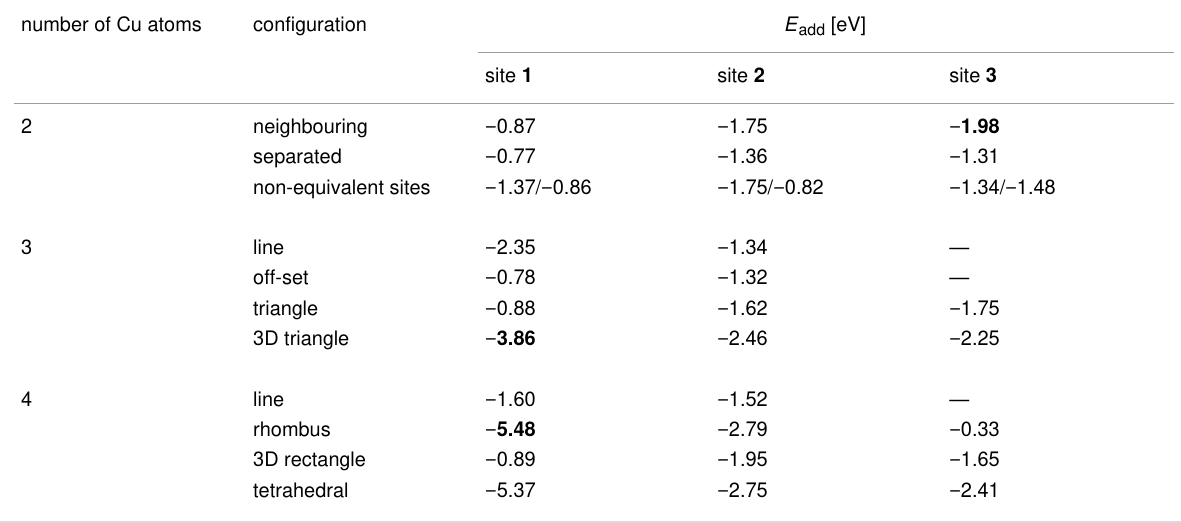
Table 3: Computed addition energies for each configuration (Cu n − 1 + Cu 1 → Cu n ) calculated using Equation 3. number of Cu atoms